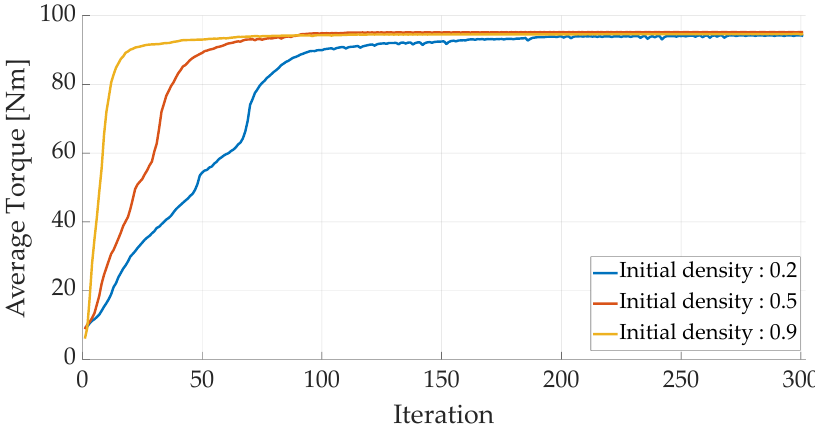
Figure 6. Results of optimizations with different initial densities.